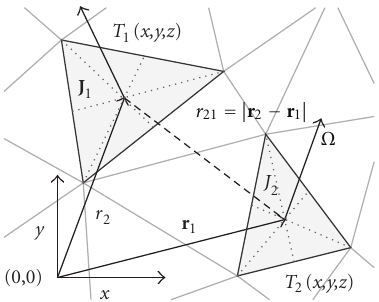
Figure 1: Distance between nonoverlapping current elements